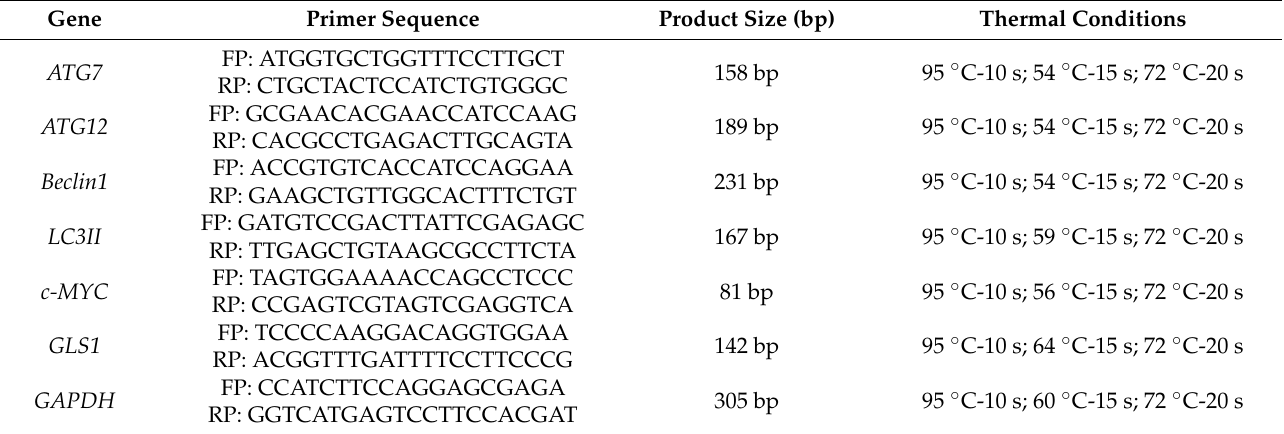
Table 1. Primer sequences of